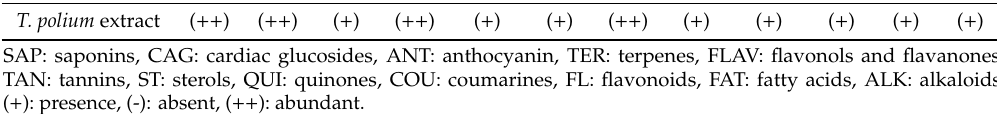
Table 3. Qualitative analysis of phytochemicals in methanolic extract of T. polium aerial parts. Phytochemical SAP CAG ANT TER Compounds